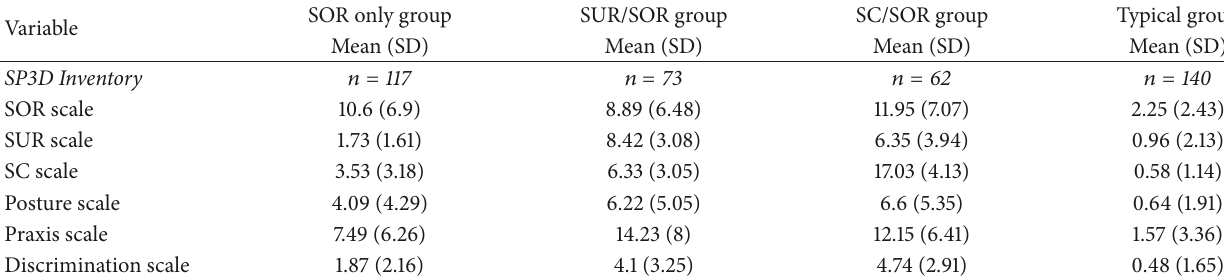
Table 1: Mean scores from SP3D Inventory group.